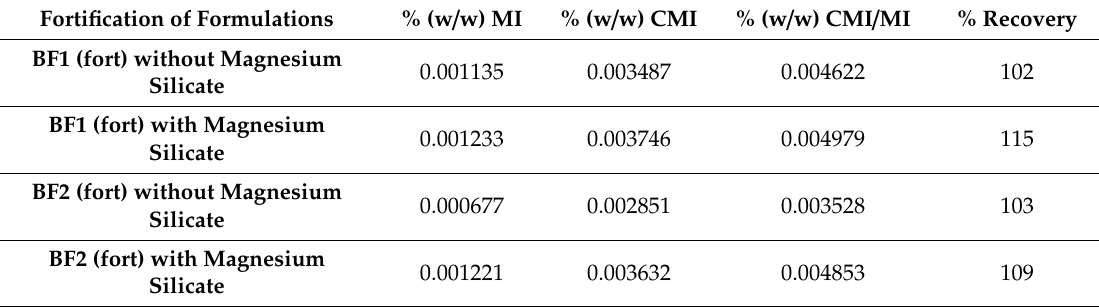
Table 3. Fortification of formulations with standard Proclin TM 150 (addition of 0.00342% CMI / MI) with and without magnesium silicate addition.